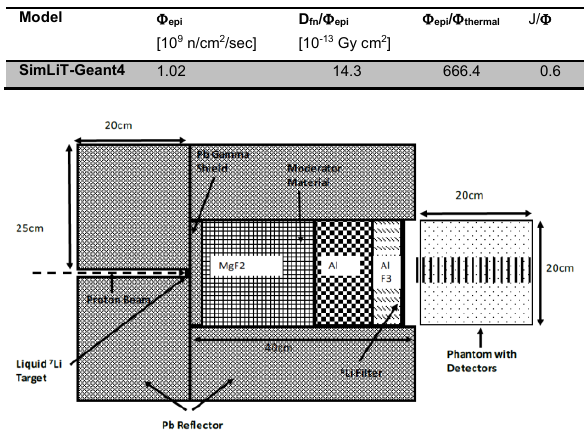
Fig. 10. BSA design for the SimLit-Geant4 calculation